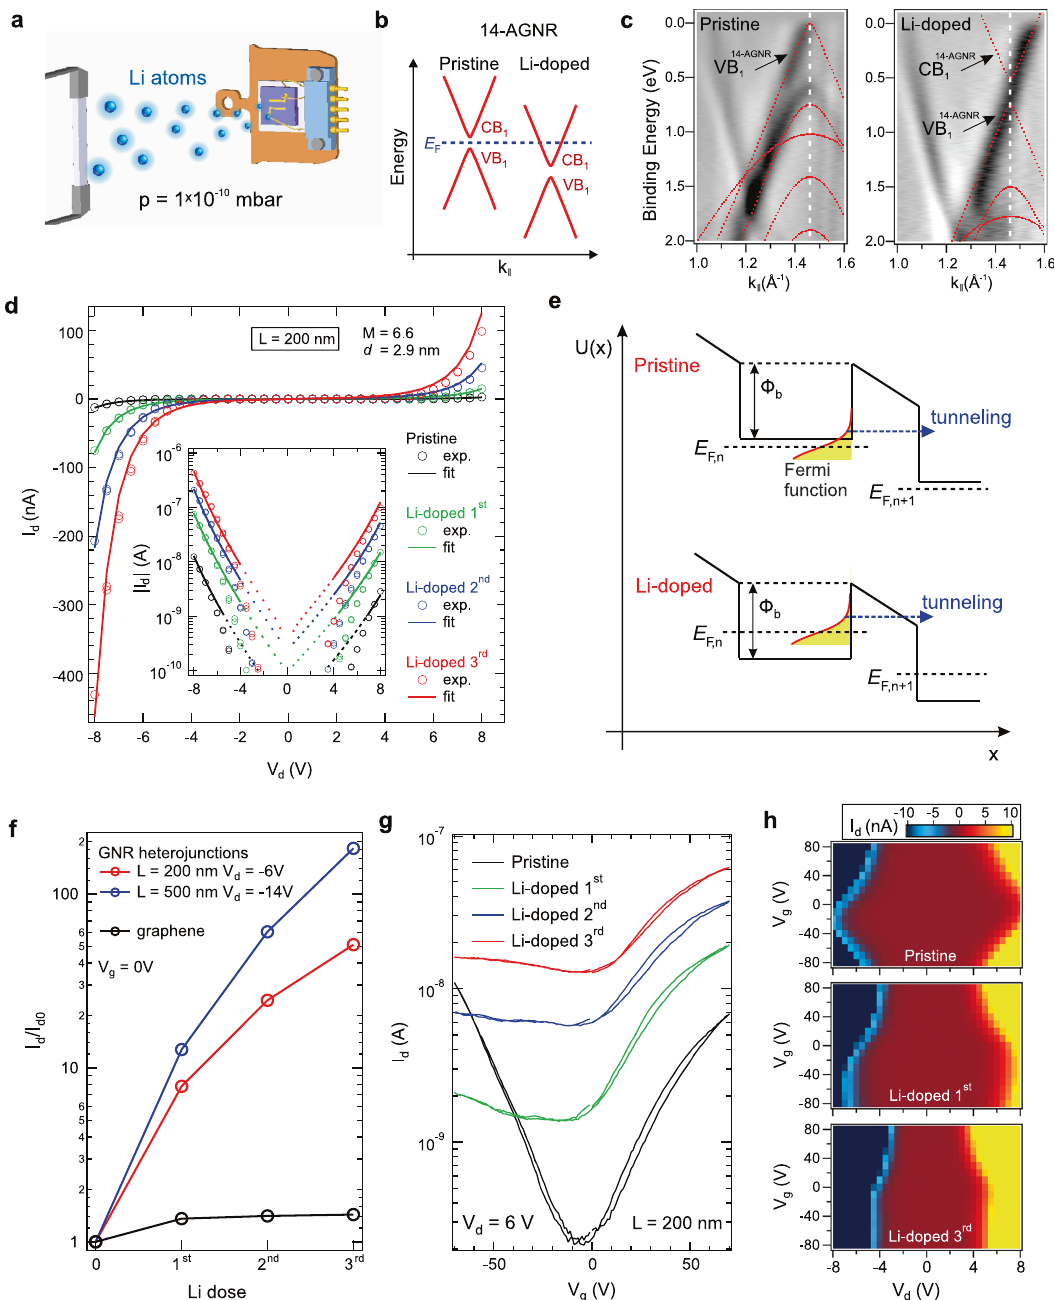
Fig. 5 Band structure and charge transport of Li-doped GNR heterojunctions. a Sketch of the experimental set-up containing a Li source and the GNR heterojunction FET mounted on a UHV compatible sample holder. b Sketch of the band structure changes of 14-AGNRs upon Li doping. c Second derivatives of ARPES scans by momentum of the GNR heterojunctions on Au(788) before (left) and after (right) Li deposition (~1 Å ) at k ⊥ = 0.71 Å − 1 (Supplementary Note 3). Dashed vertical white line denotes the center of the second Brillouin zone of AGNRs. Red dashed lines are the calculated electronic band structure, aligned in energy to the ARPES data. d I d – V d characteristics before (pristine sample) and after deposition of three identical Li doses (~0.1 Å each) in linear and log (inset) scales for the L = 200 nm device. Experimental points (exp.) are shown by circles, the fi t is indicated by solid lines. e Schematic illustration of the potential pro fi le U ( x ) across a tunneling barrier for pristine and Li-doped GNR heterojunctions. f The ratio (log scale) of current after Li doping I d to the current in pristine sample I d0 for three Li doses for the L = 200nm device at V d = − 6 V, for the L = 500nm device at V d = − 14V, and for the graphene FET (Supplementary Note 8), all at V g = 0 V. g I d – V g characteristics of the L = 200nm device at V d = 6 V for three Li doses. h Color maps of the dependence of I d on V g and V d for the pristine and Li-doped L = 200 nm device. All transport measurements were performed at